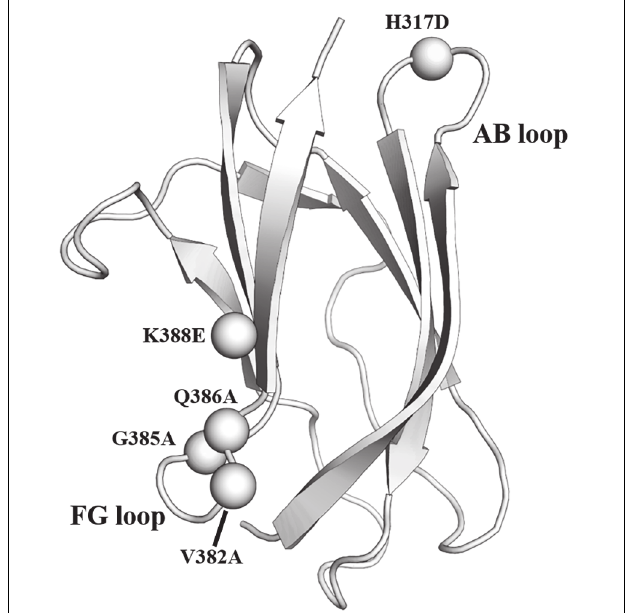
FIGURE 3 | Resurfaced domain III of the envelope glycoprotein. Cartoon representation of domain III of DENV2 envelope glycoprotein. The residues in the FG loop and AB loop that were mutated in the rsDIII-Ala30 are shown as spheres and labeled. PDB ID: